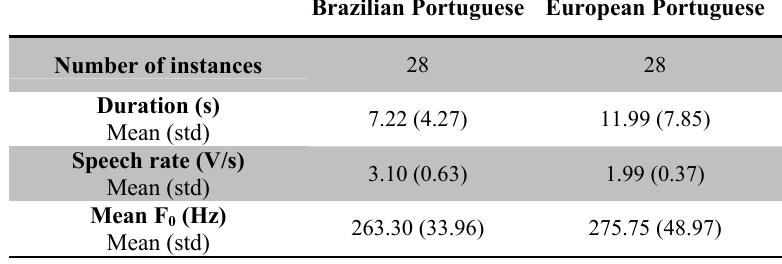
Table V: Basic statistical information about the utterances grouped grouped by Portuguese singing